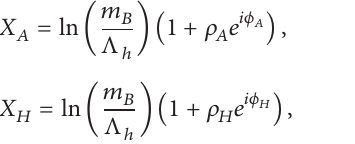
0 → 𝜌 0 (𝜔)𝜌 0 (𝜔) → 𝑟 0 ( −